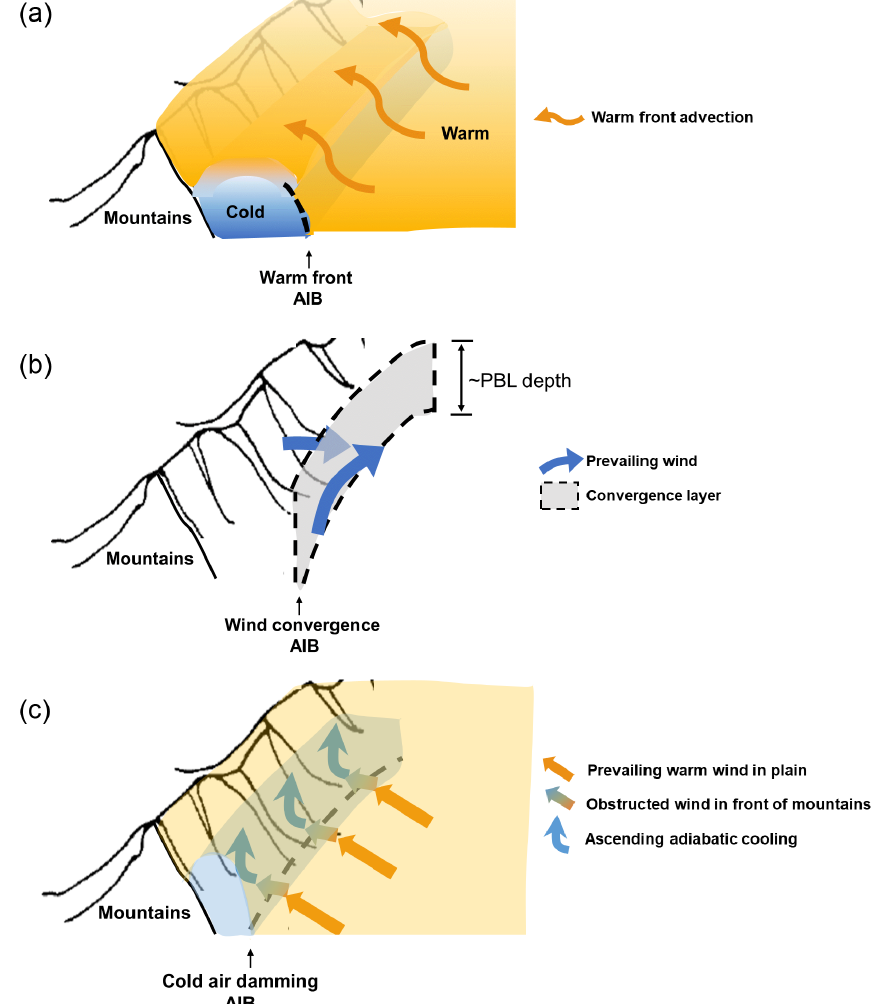
Figure 1. Schematic diagram showing the conceptual model of PBL spatial structures under three pollution categories. (a) Frontal category: the blue-shaded and orange-filled areas represent the isolated and stable cold air mass ahead of the warm front and the warmer well-mixing atmosphere behind the front. The orange arrows indicate warm front advection. (b) Wind shear category: two blue arrows represent the airflows ahead of and behind the trough. The gray-filled area indicates the dynamical convergence layer with a depth comparable to the boundary layer height. (c) Topographic obstruction category: the light-blue-filled area indicates the cold-air damming at the foot of the windward mountains. Terrain obstruction disrupts the geostrophic balance so that the southerly warm advection weakens (long orange arrows) and turns to the easterly cold advection (short gradient-color arrows), and meanwhile, the air mass accumulates to produce a lift cooling (upward blue arrows). Dashed black lines in (a–c) indicate the warm front AIB, wind convergence AIB, and cold-air damming AIB, respectively. The PBL spatial structure under the first category has been revealed by Jin et al. (2021). For the latter two categories, their PBL three-dimensional structures are discussed in Sect. 3.3 of this